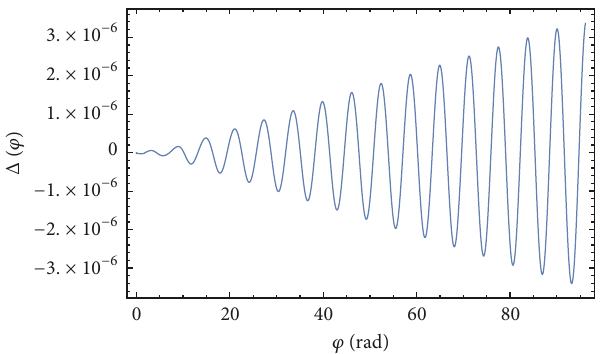
Figure 4: The absolute difference Δ(𝜑) between the numerical solution 𝑈(𝜑)| num and the truncated Laplace-Adomian power series solution 𝑈(𝜑)| LADM of Eq. (123) for 𝑎 = 0.015 .